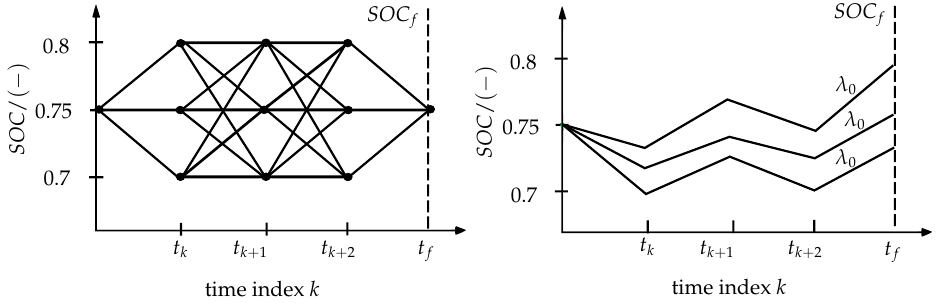
Figure 3. Principle DP ( left ) and ECMS with iteratively determined λ 0 ( right ) regarding SOC , based on [9,56]. For DP, the entire state space must be discretized to calculate the costs of any control and state combination. When applying an ECMS, no state space discretization is needed. The iteratively determined λ 0 finally leads to an optimal control ensuring CS